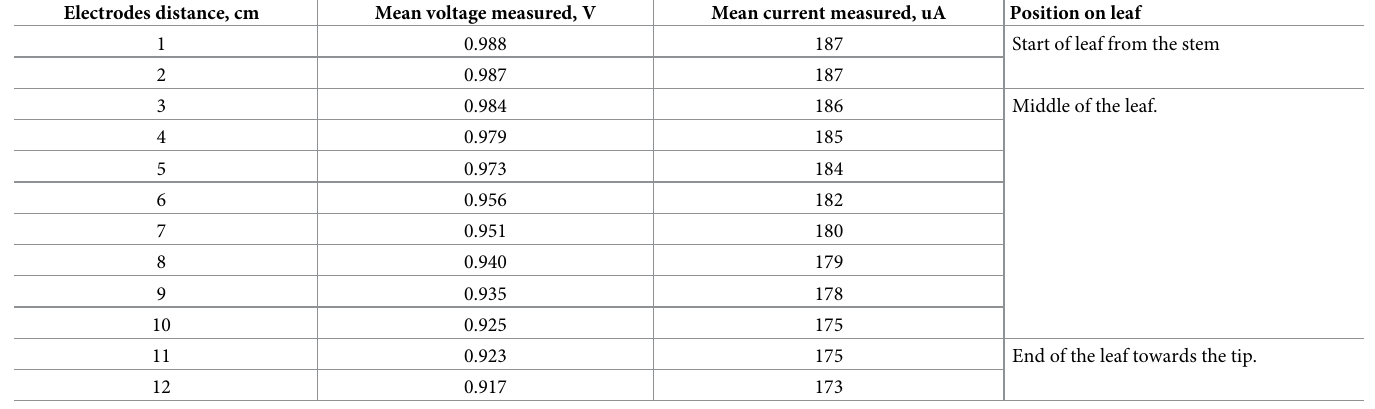
Table 4. Voltage and current measured by varying the distance between an electrodes